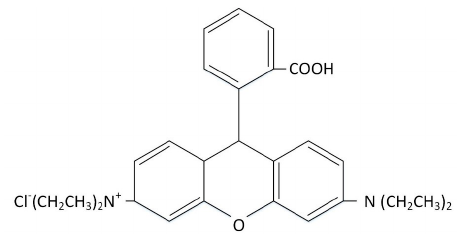
Figure 9. The chemical formula of Rhodamine